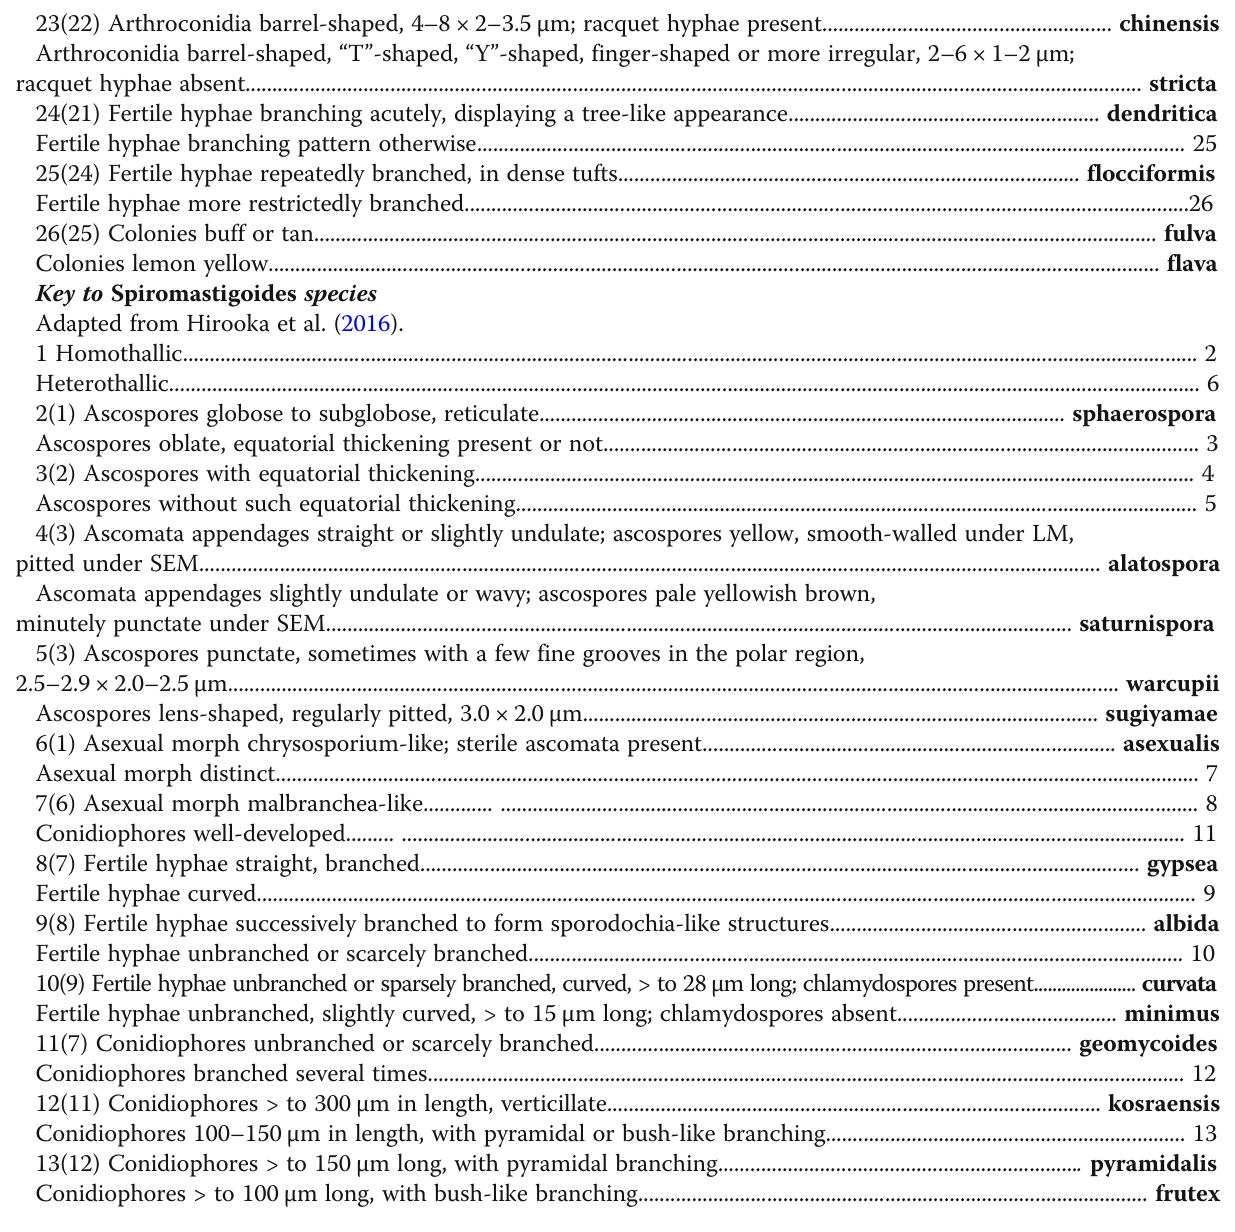
Arthroconidia barrel-shaped, “ T ” -shaped, “ Y ” -shaped, finger-shaped or more irregular, 2 – 6 × 1 – 2 μ m; 24(21) Fertile hyphae branching acutely, displaying a tree-like appearance.......................................................... dendritica